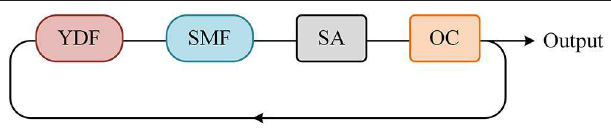
FIGURE 1 | Schematic of the NOLM mode-locked Yb-doped fiber